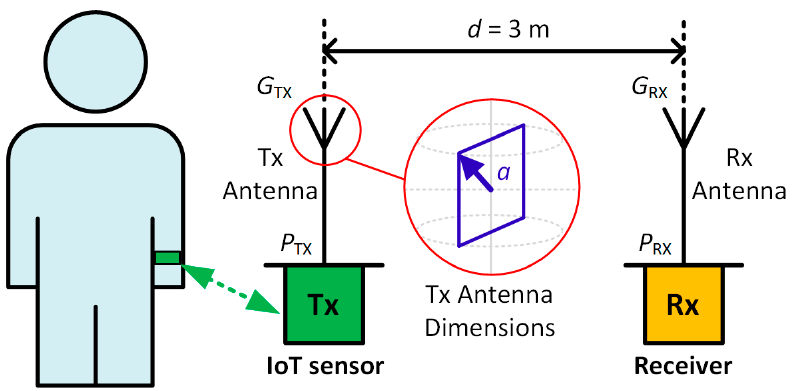
Figure 2. IoT sensor (Tx) placed on the human wrist communicating with a remote receiver device (Rx).